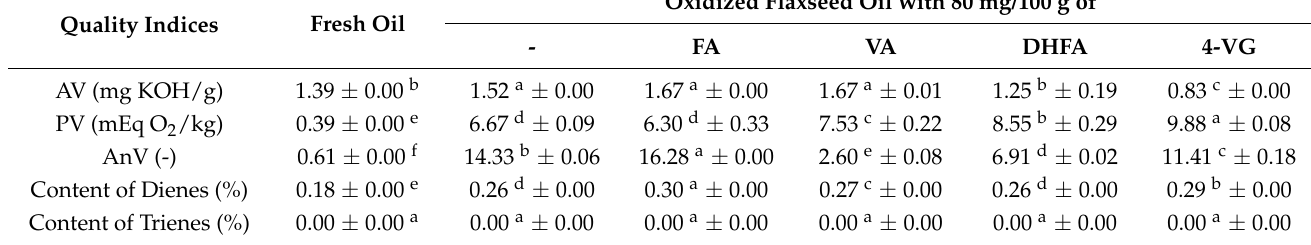
Table 2. Quality indices (x ± SD) of fresh cold-pressed flaxseed oil and oil oxidized at 60 ◦ C without and with phenolic